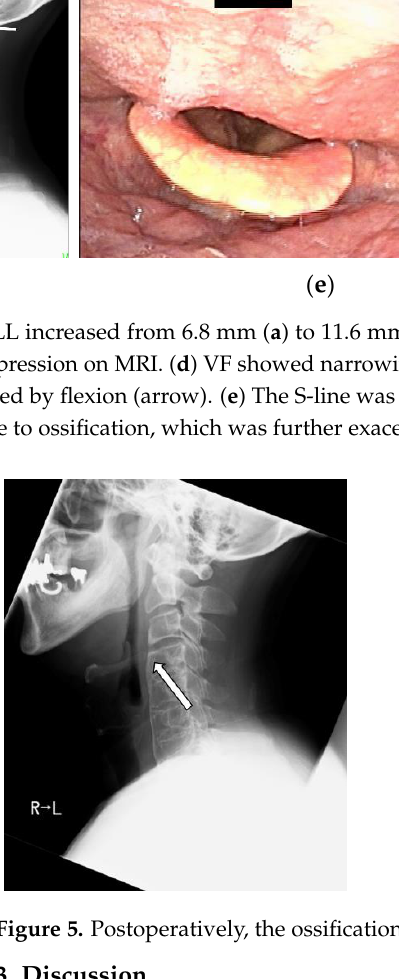
Figure 5. Postoperatively, the ossification was reduced by resection (arrow).